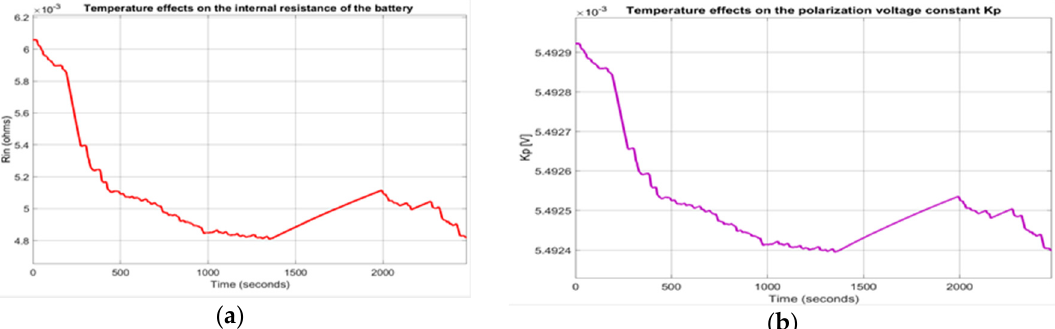
Figure 11. ( a ) The internal battery (cid:1844) (cid:3036)(cid:3041) ((cid:1846)) at ambient temperature (20 °C); ( b ) The polarization constant at ambient temperature K p (T) (20 °C).